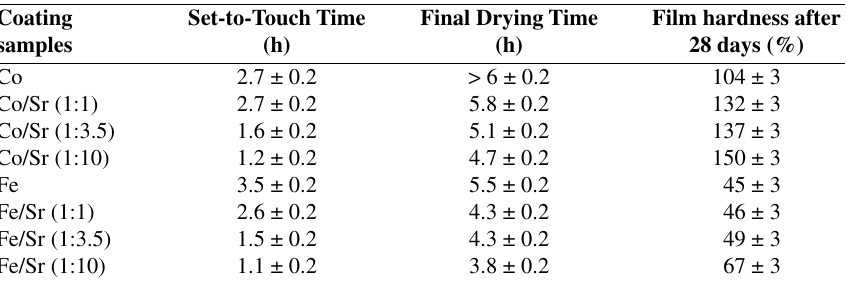
Table 2. Set-to-Touch Time, Final Drying Time values and Relative film coating hardness after 28 days for HS alkyd coatings using different drier